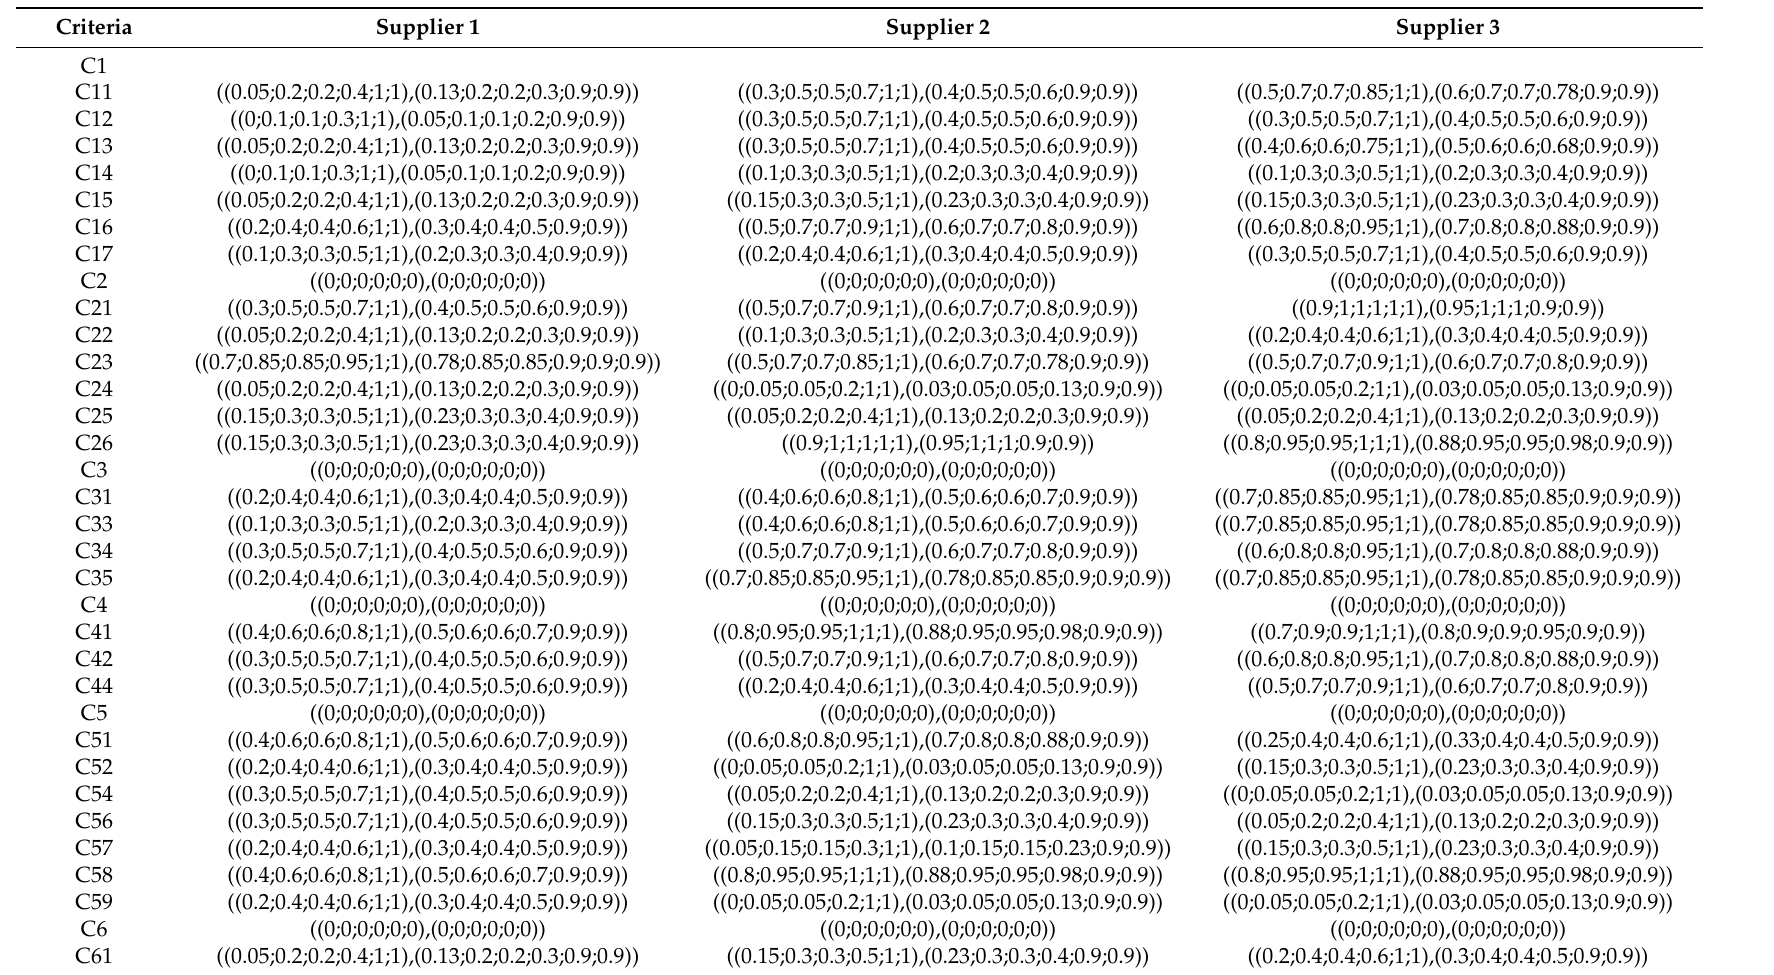
Table 5. The aggregated evaluation